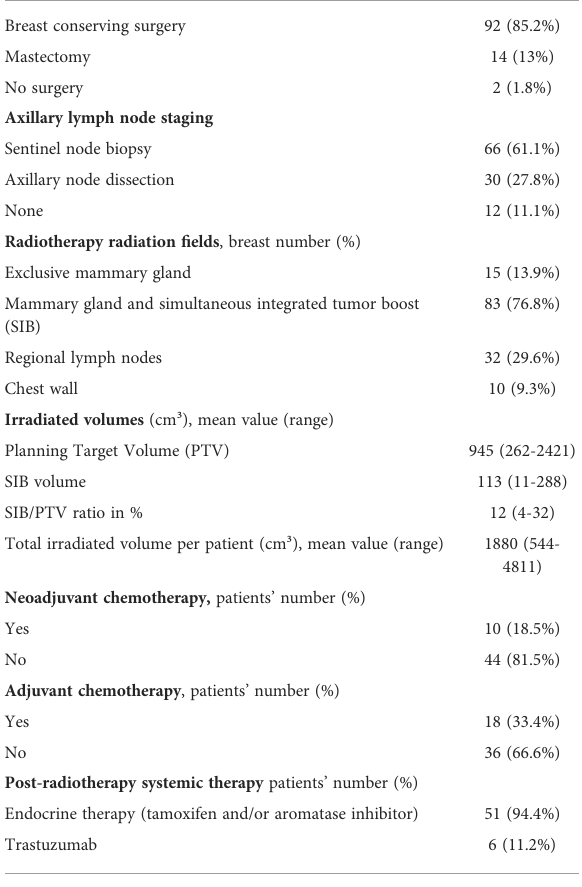
TABLE 2 Treatment characteristics of patients (n=54) and breast cancer lesions (n=108).